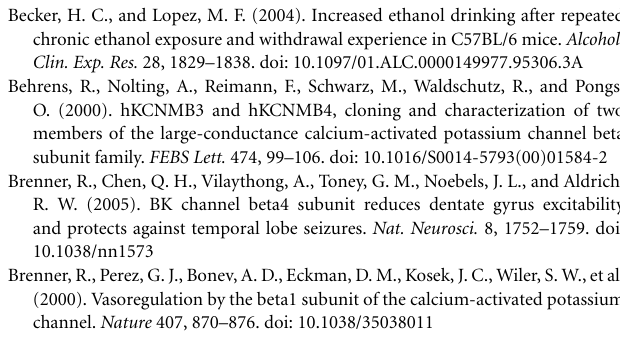
Figure S1 | Intermittent access to ethanol drinking produces intoxicating blood alcohol levels. BALs were measured in C57Bl/6J mice offered continuous or intermittent access to ethanol (20% w:v) along with water. Tail blood was sampled 1h (A) or 24h (B) after the ethanol bottle was reintroduced (intermittent) or repositioned (continuous). Linear regression analysis detected a significant correlation between BAL and ethanol intake when blood was sampled 1h after ethanol bottle reintroduction in mice given intermittent access [ R 2 = 0 . 66, F ( 1 , 5 ) = 7 . 61, p = 0 . 05, dashed line], but not under other circumstances. In the former condition, BALs were above the intoxication threshold (80mg/dL) in all mice